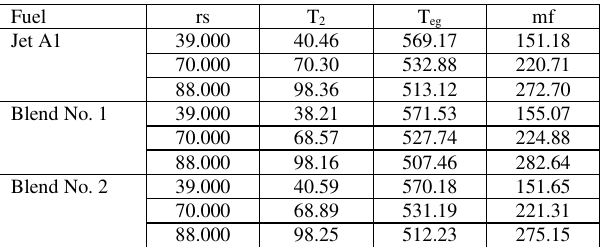
Table 1. The average results of tests on MiniJetRig